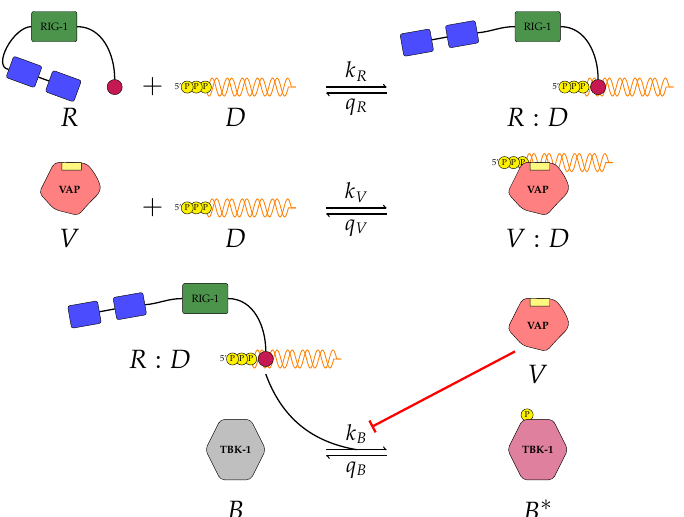
Figure 1. A first model of type I IFN inhibition by VAP (model 1). Model 1 considers the following molecules: RIG-I denoted R , viral RNA denoted D , VAP denoted V , and TBK1 denoted B . In this model there are six reactions and three molecular complexes. Free VAP inhibits phosphorylation of TBK1, as indicated by the flat head red